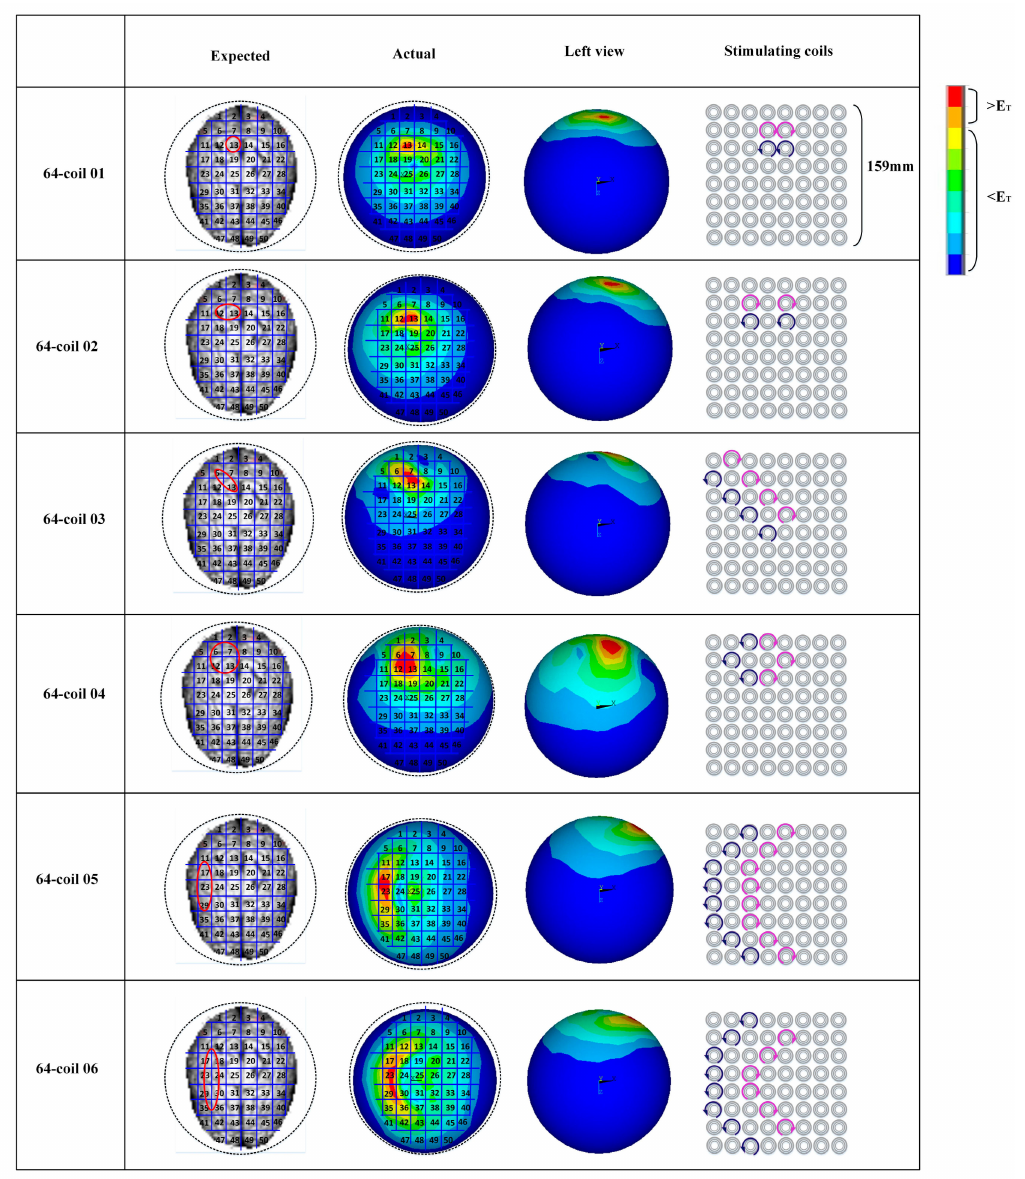
Figure 11. Stimulation results targeted at different cortical tissues. The units in red solid circles are interested regions. The activated parts and energized coils are shown correspondingly. Here, currents in coils are indicated by arrows of different